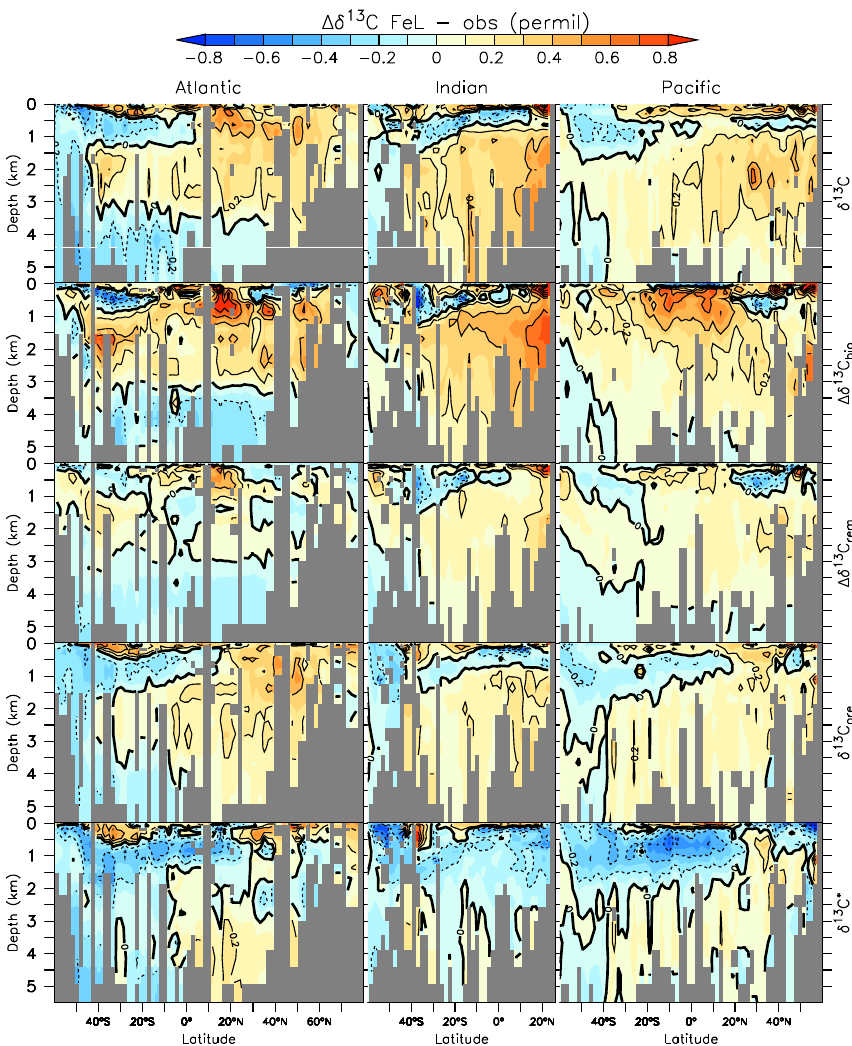
Fig. 13. As Fig. 6 but for difference model FeL minus